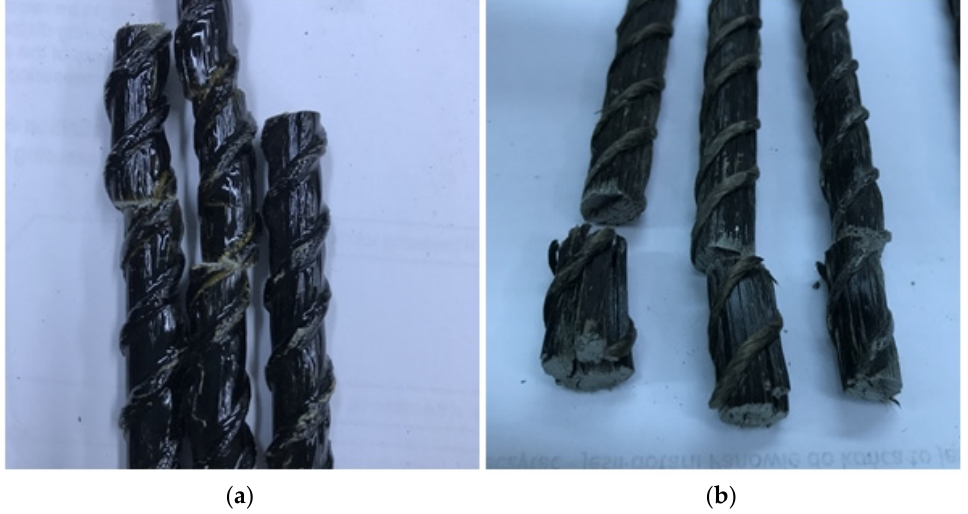
Figure 7. Surface changes observed after the shear test. Sample Ø8 previously heated to 200 ◦ C for 2 h: yellow/orange color visible at the shear point ( a ), delamination of the Ø10 bar structure ( b